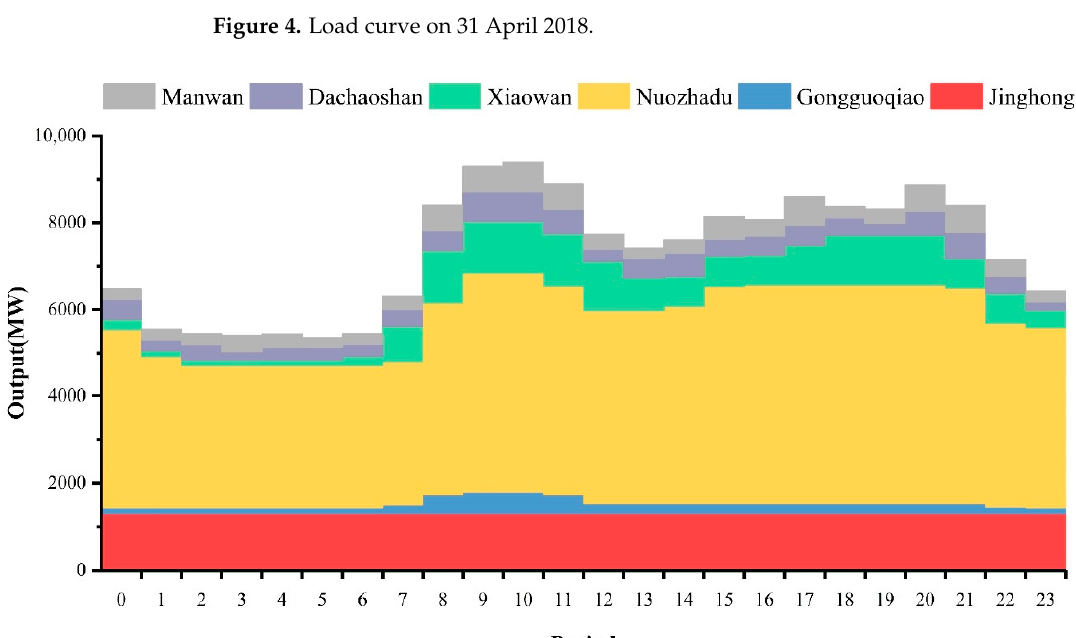
Figure 5. Historical hourly power generations.